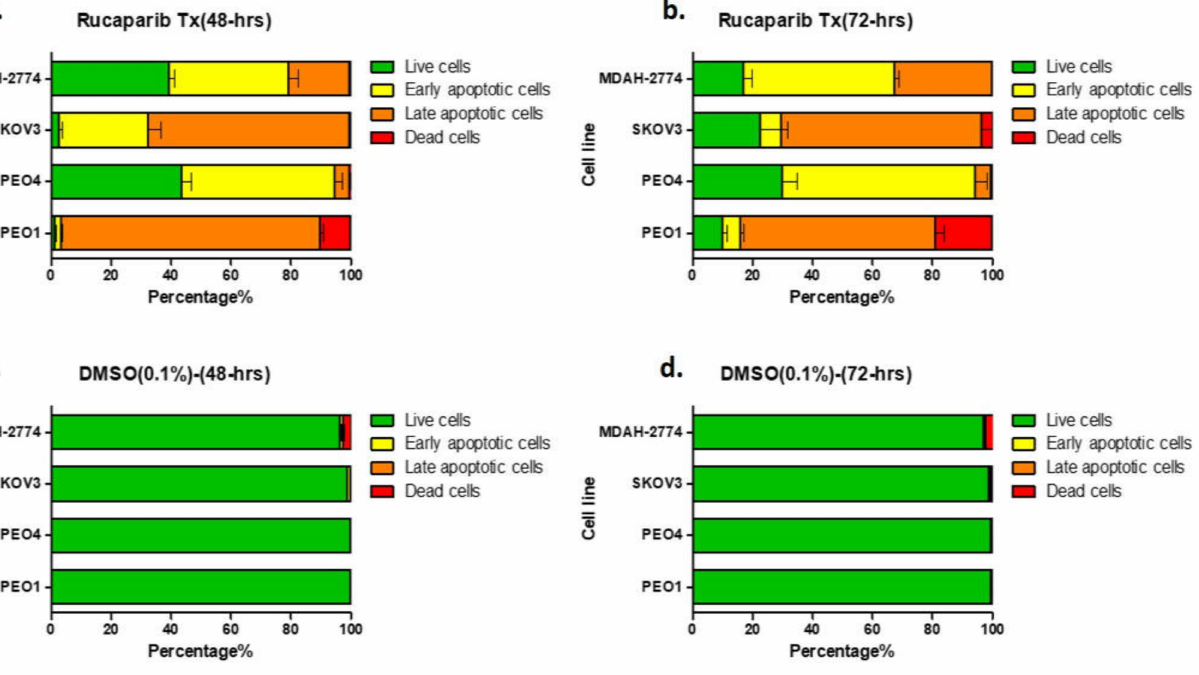
Figure 3. Annexin V assay. Proportion of cells demonstrating features of early apoptosis, late apoptotic cells, or no apoptotic features (live cells) in comparison to the proportion of dead cell, 48-h ( a ) and 72-h ( b ) after rucaparib treatment. Panels ( c , d ) are untreated controls.